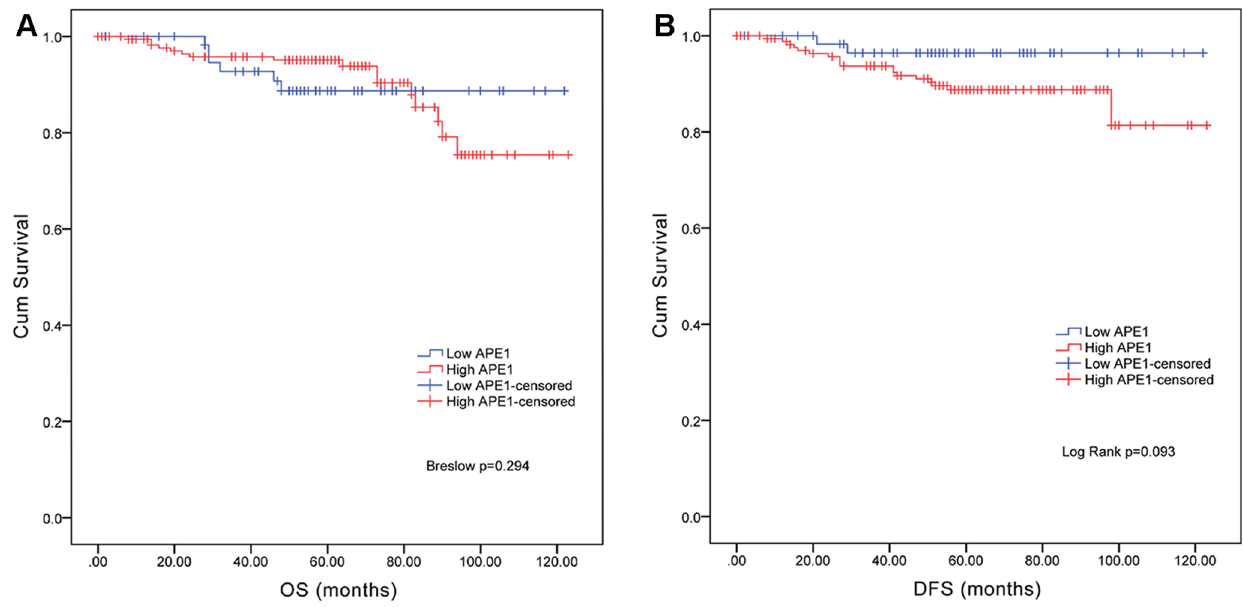
Figure 2. Kaplan-Meier survival curves based on APE1 expression levels. A . Overall survival (OS). B . DFS. There was no significant difference in OS rates between the APE1 high-level expression group and the APE1 low-level expression group. There was a difference in DFS rates; patients in the APE1 low-level expression group showed a tendency to relapse. (High APE1 ( red ), low APE1 ( blue ).)